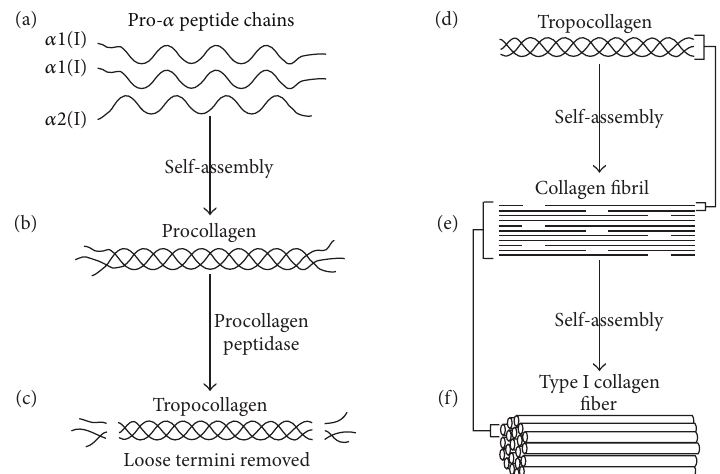
Figure 1: The process of type I collagen synthesis. (a) Two identical 𝛼 1(I) and one 𝛼 2(I) peptide chains self-assemble to form procollagen (b). (c) Procollagen peptidase removes loose termini to create a type I tropocollagen molecule (d). Tropocollagen molecules self-assemble to form a growing collagen fibril (e). Self-assembly of collagen fibrils forms a type I collagen fiber